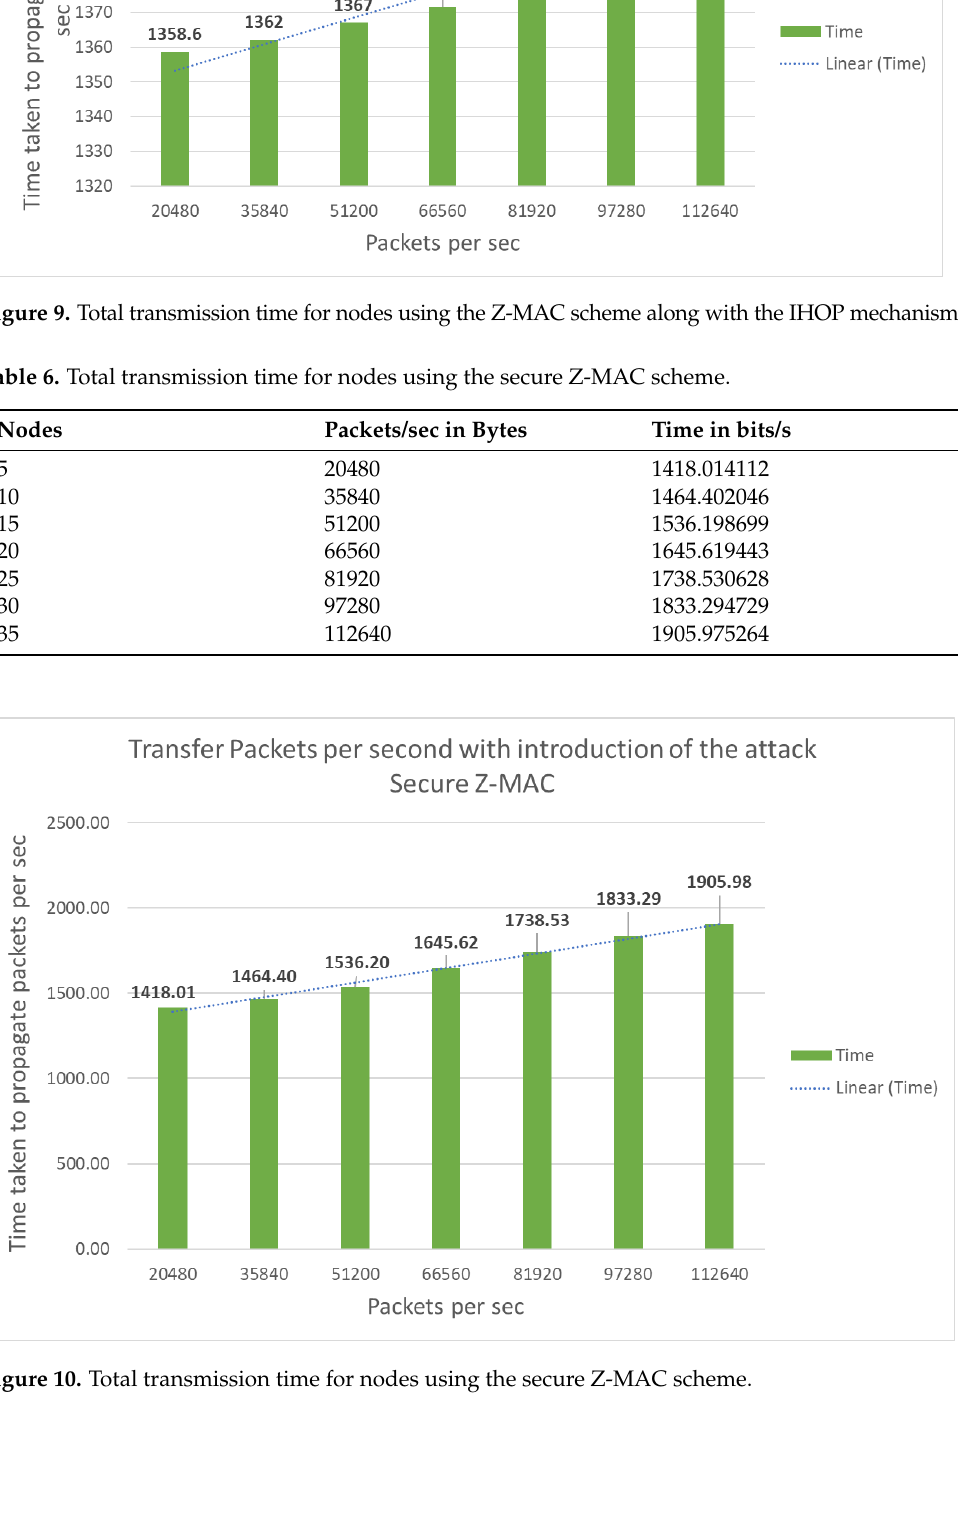
Table 7. Total transmission time during a flooding attack for nodes processed using the secure Z- MAC scheme compared to Z-MAC. Nodes Packets/sec in Bytes Z-MAC Transmission Time in bits/s